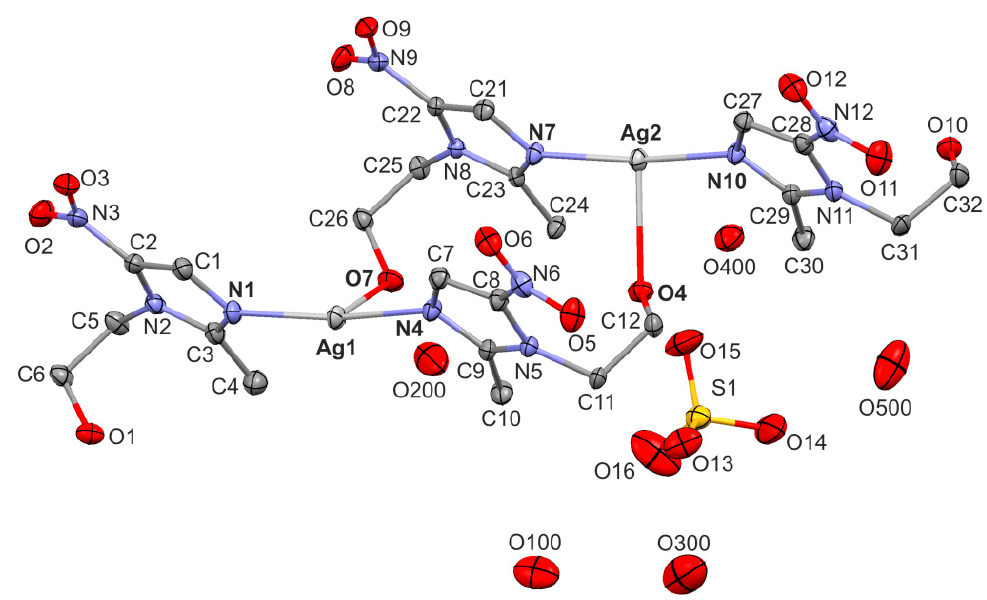
Figure 5. Mercury [28] representation of an asymmetric unit of [Ag(MTZ) 2 ] 2 SO 4 · 5H 2 O. Displacement Figure 2. Mercury [28] representation of an asymmetric unit of [Ag(MTZ) 2 ] 2 SO 4 ∙ 5H 2 O. Displacement